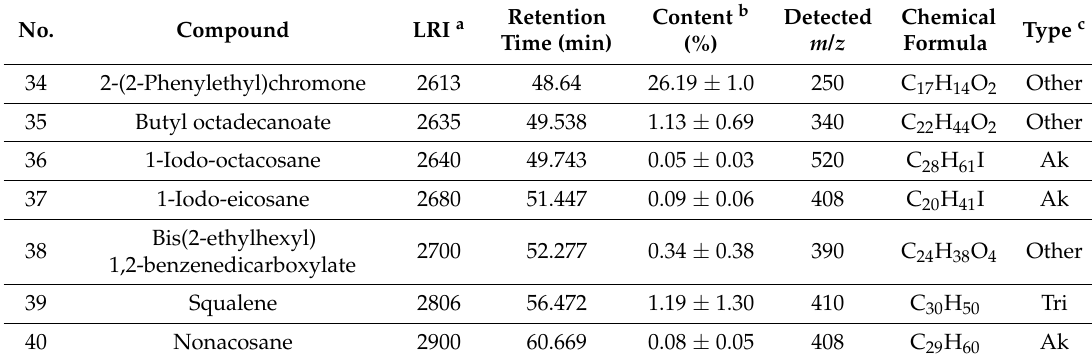
a LRI: Linear retention index as tested on SH-Rxi-5Sil column using the series of C8–40 n -alkanes; b Values are the mean ± standard error ( n = 3); c Ak: alkane; Ar: aromatics; S: sesquiterpene; T: terpene; Tri: triterpene.